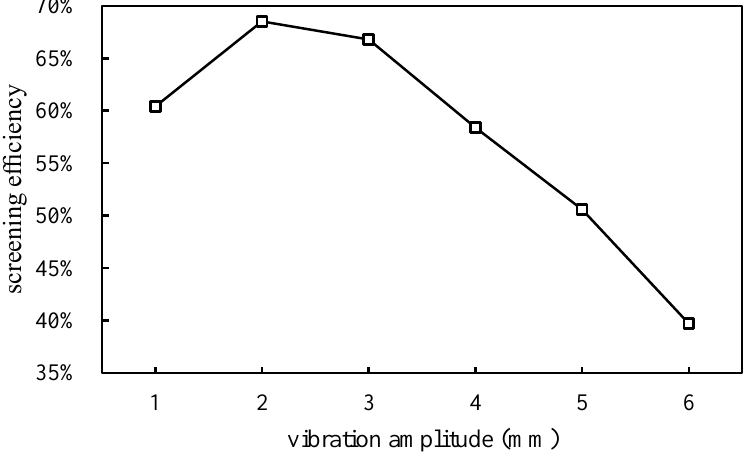
Figure 10. Screening e ffi ciencies of a cantilevered vibrating sieve (CVS) for di ff erent vibration amplitude.